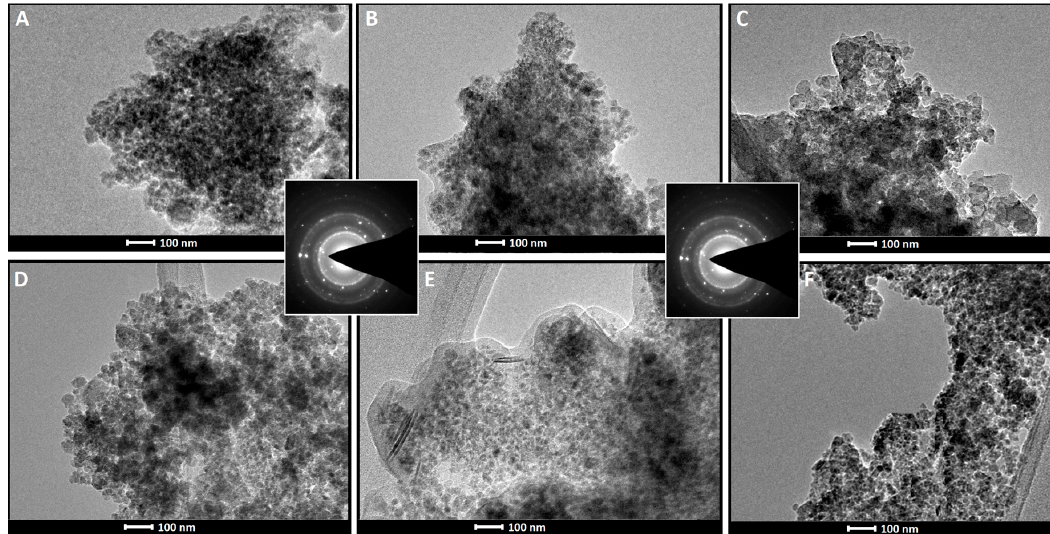
Figure 3. TEM images of ( A ) Coll/Glu (Fe 3 O 4 ); ( B ) CS–Coll/Glu (Fe 3 O 4 ); ( C ) CS/Glu (Fe 3 O 4 ); ( D ) Coll/SqA (Fe 3 O 4 ); ( E ) CS–Coll/SqA (Fe 3 O 4 ); ( F ) CS/SqA (Fe 3 O 4 ) nanoparticles.